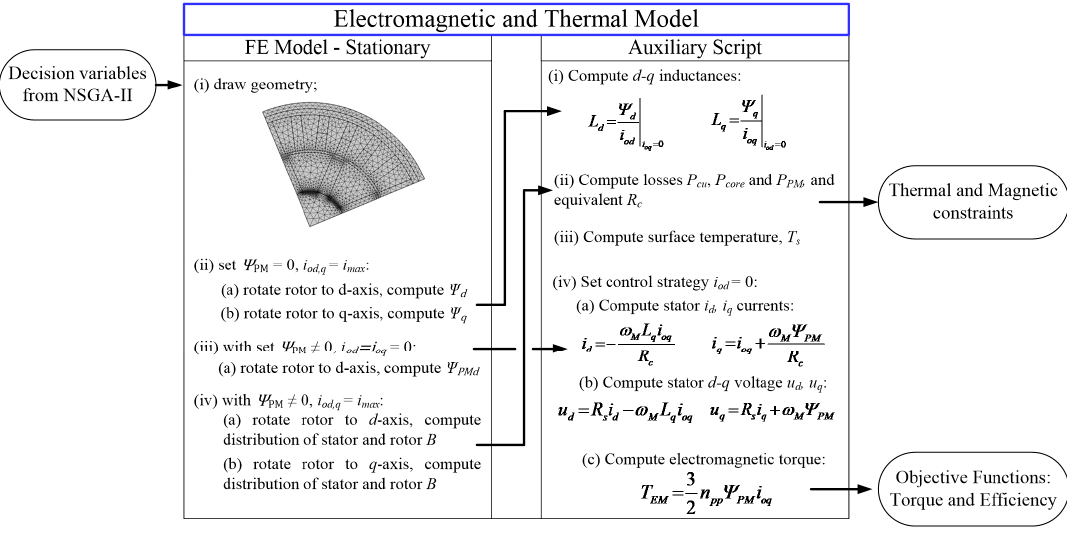
Figure 10. Objective function evaluation.